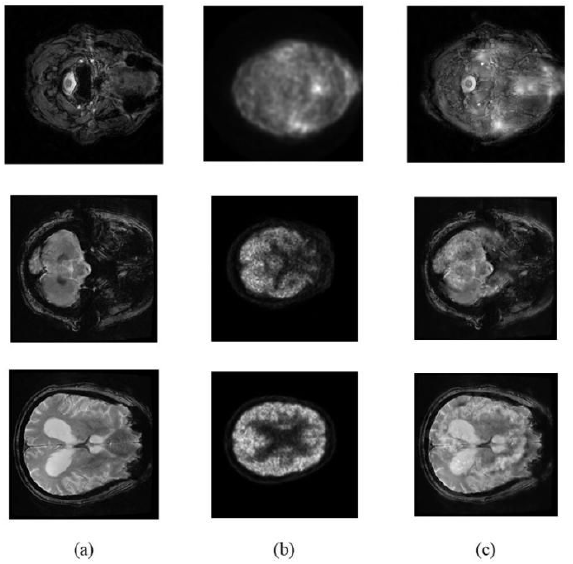
Figure 11. This figure displayed the different modalities space serial images of the same patient and their fusion result. ( a ) The original MRI images. ( b ) The original PET images. ( c ) The fusion results of the corresponding MRI and PET